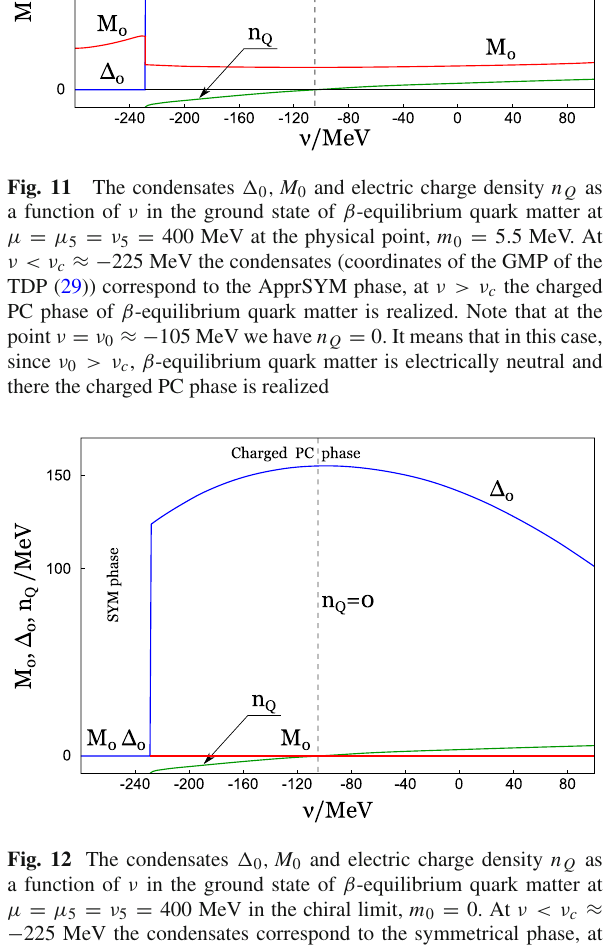
Fig. 12 The condensates (cid:4) 0 , M 0 and electric charge density n Q as a function of ν in the ground state of β -equilibrium quark matter at μ = μ = ν = 400 MeV in the chiral limit, m = 0. At ν < ν ≈ c 0 5 5 − 225 MeV the condensates correspond to the symmetrical phase, at ν > ν β -equilibrium matter is realized. Note c the charged PC phase of that at the point ν 0 > ν c , where ν 0 ≈ − 105 MeV, we have n Q = 0, i.e. the realization of the charged PC phase in electrically neutral and β -equilibrium quark matter